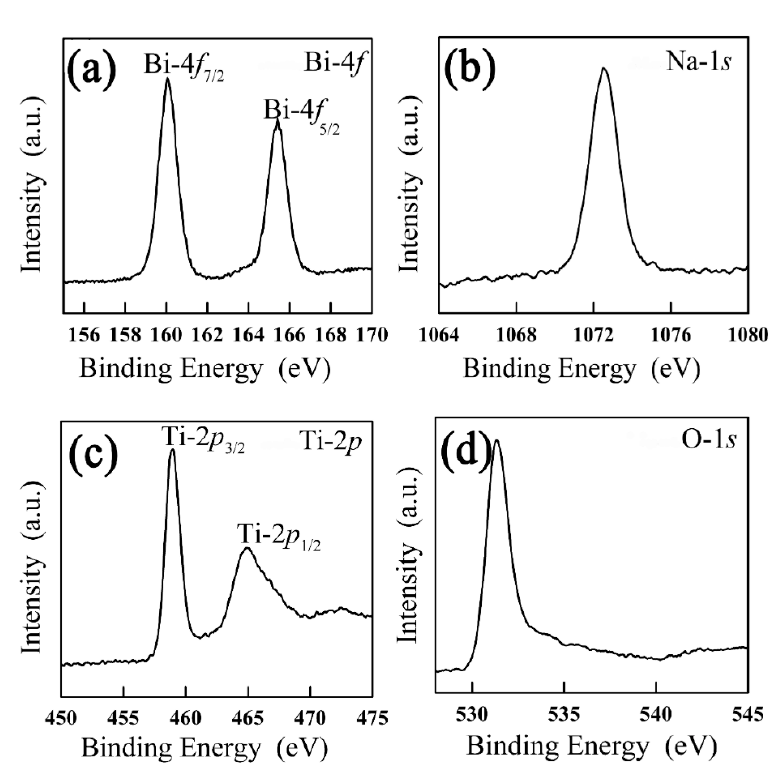
Figure 3. The XPS spectra of BNT: ( a ) Bi 4 f , ( b ) Na 1 s , ( c ) Ti 2 p and ( d ) O 1 s .